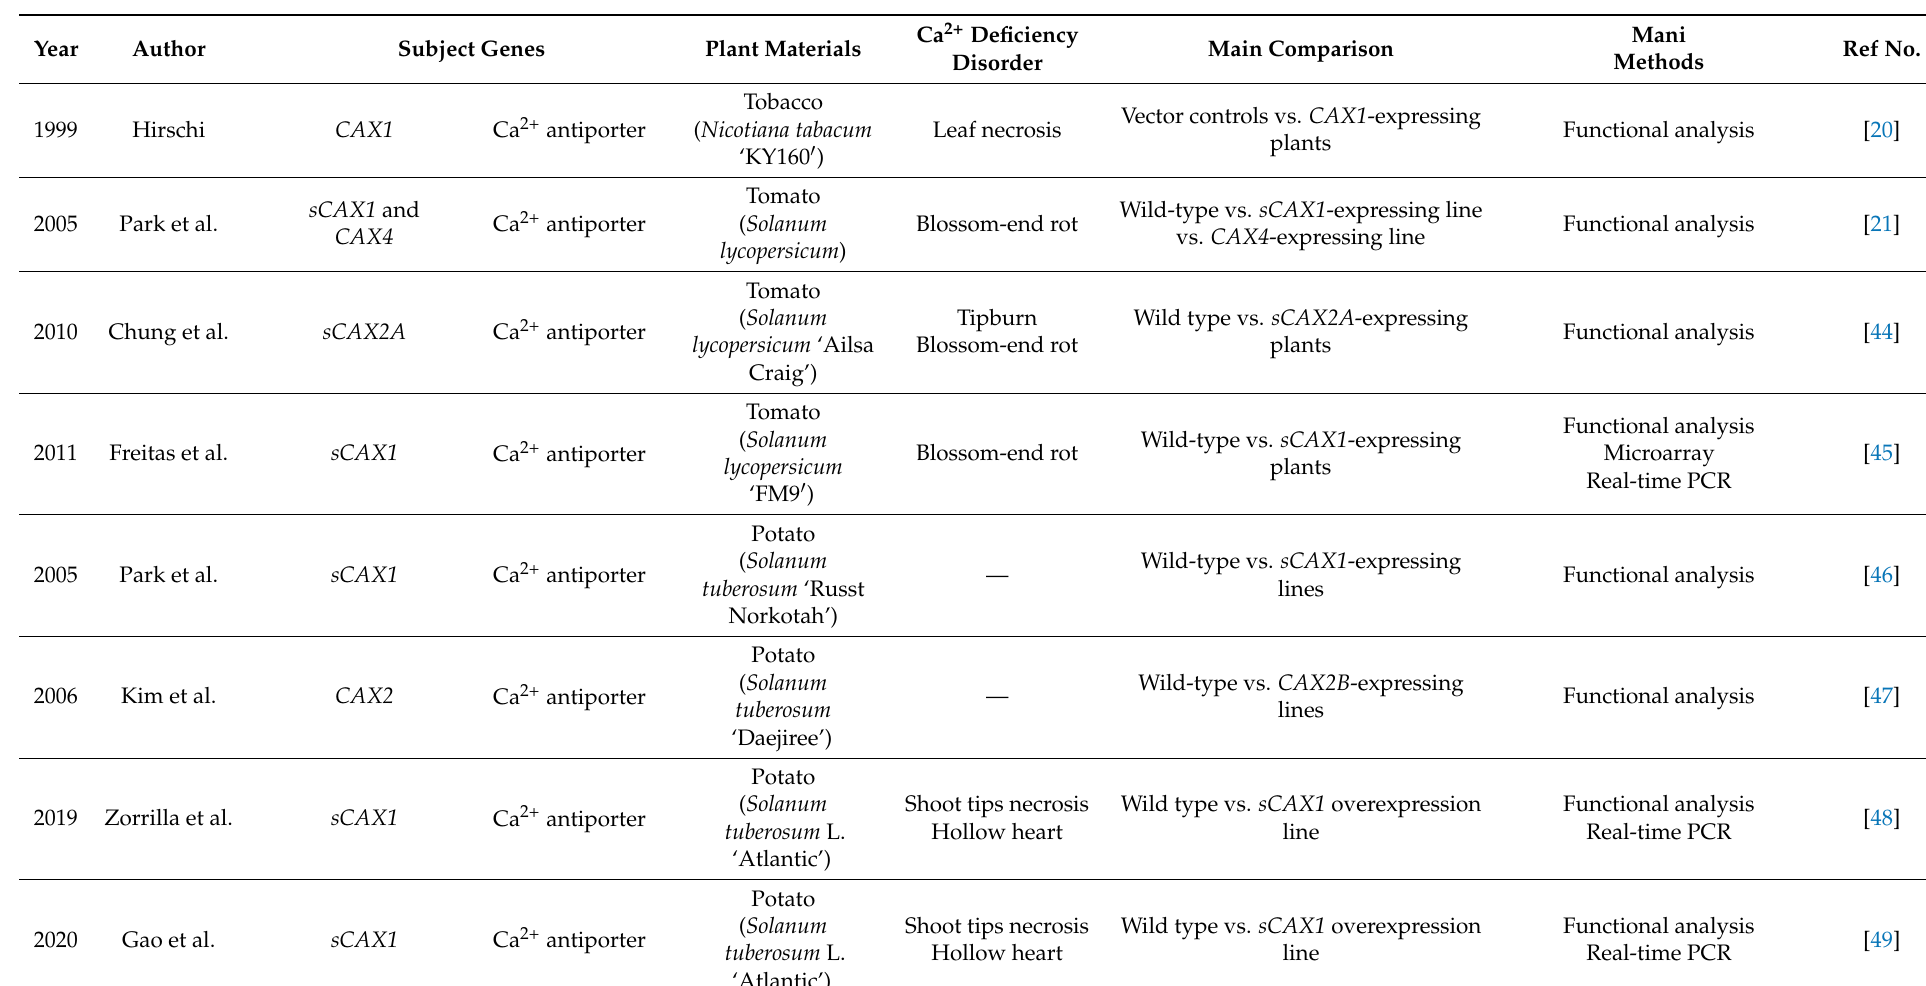
Table 2. Overview of the studies involving the functional analysis of genes associated with Ca 2+ deficiency disorders and Ca 2+ accumulation in plant organs obtained via Search